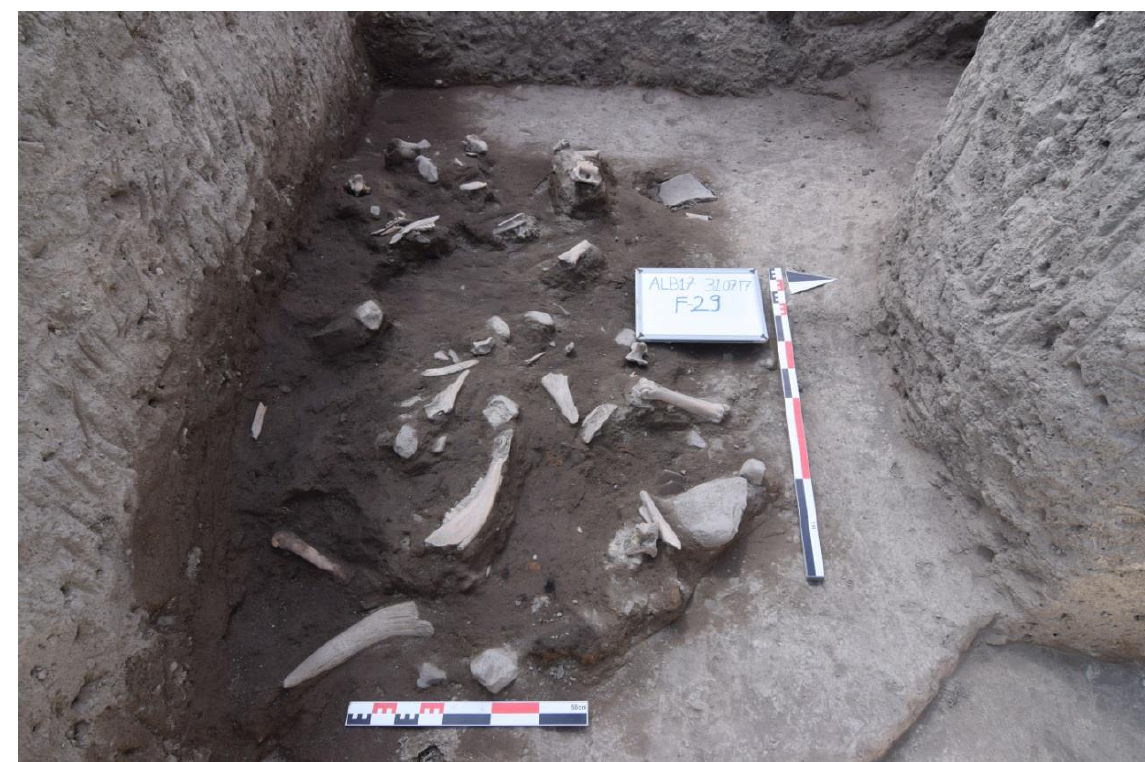
Figure 2. Topography and excavated areas of Alaybeyi Höyük: the modern road divided the site in east and west sections (photo from Alaybeyi Höyük Archive).